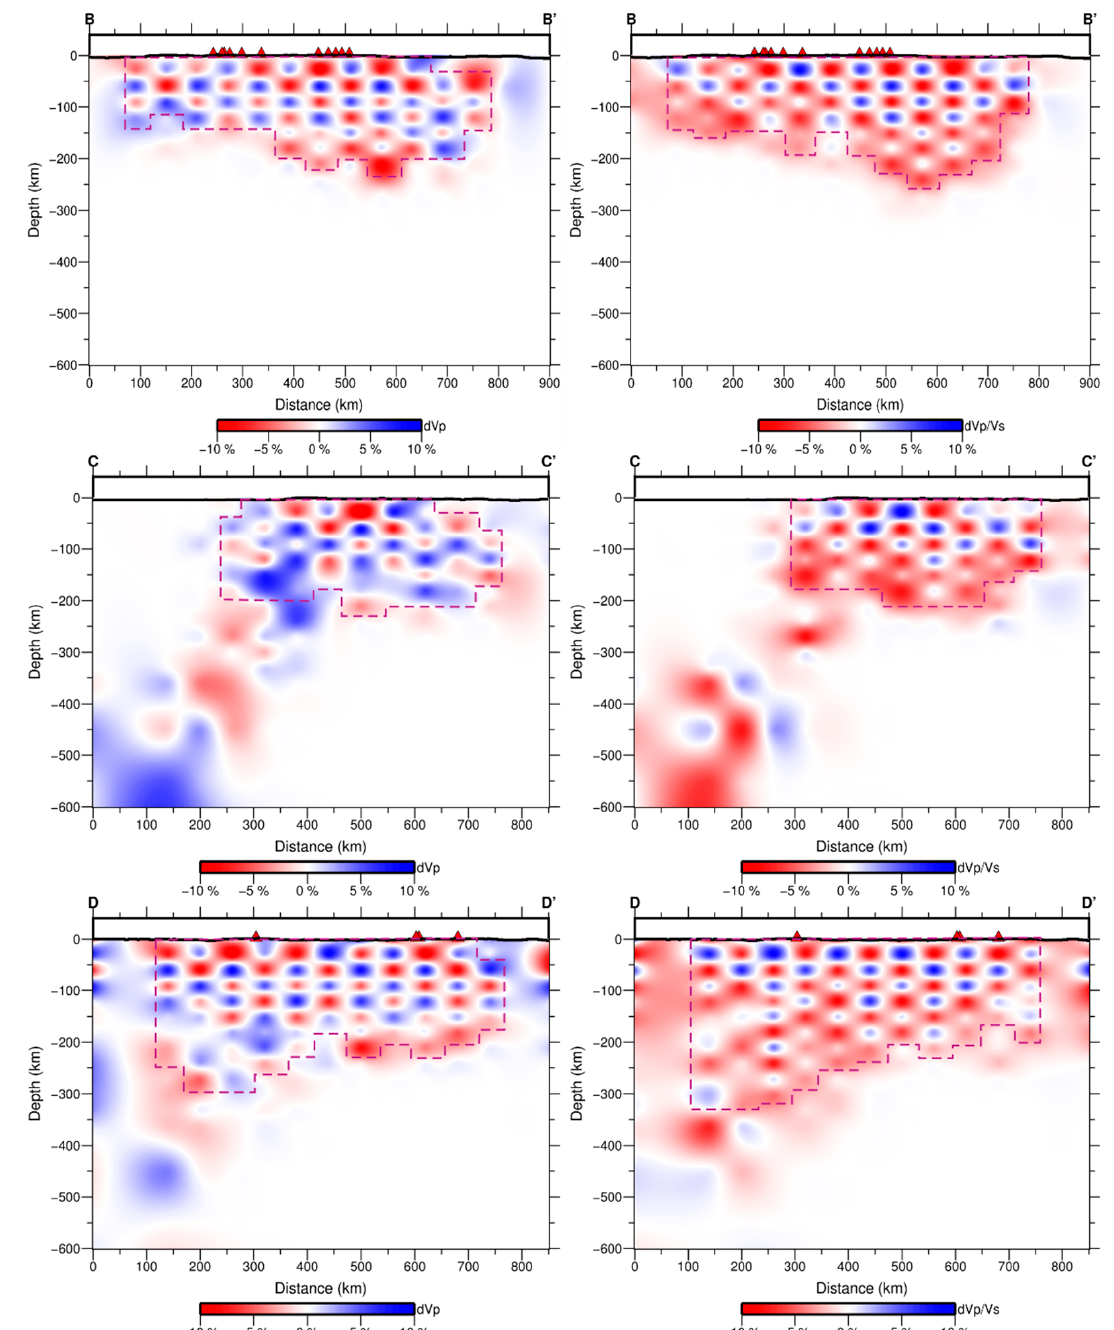
Figure 5. The vertical cross-section of CRT profiles. Profile A-A ′ (south–north), B-B ′ (south–north), C-C ′ (west–east), and D-D ′ (west–east) are vertical cross-sections of the CRT recovery model from the inversion process. The purple dashed line is the positive CRT recovery area for tomographic interpretation. The first column is Vp perturbation, the second column is Vp/Vs perturbation, and the red triangles signify volcanoes.